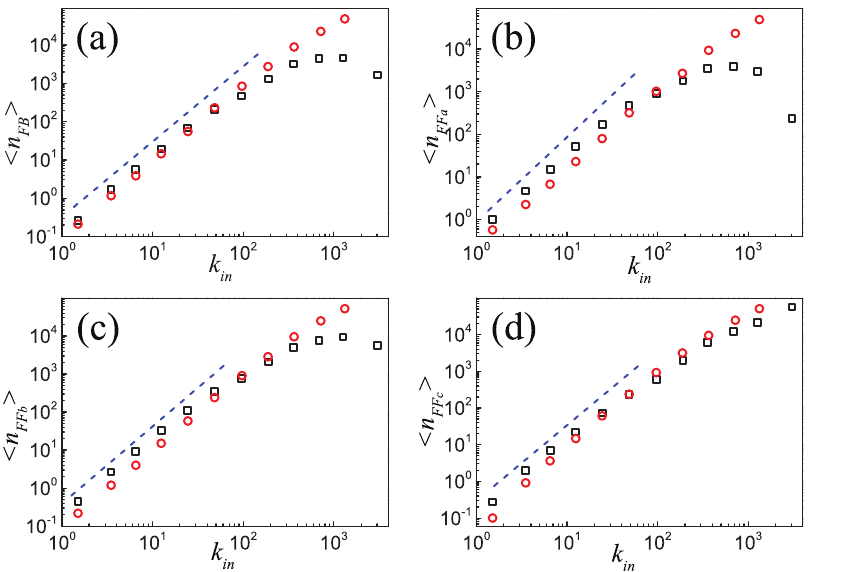
Figure 8. Mean number of the four closed triples for nodes with the same indegree in the Epinions social network and the model. Results for the mean number of closed triples corresponding to (a) FB , (b) FF a , (c) FF b , and (d) FF c loops for nodes with the same indegree are shown for the Epinions social network (black squares) and simulated network (red circles) based on the model. Analytic treatment (see Eq. (28)) gives a scaling behavior with an exponent 2 , as indicated by the dash lines. Data points are averages over the logarithmic bins of the indegree k in .